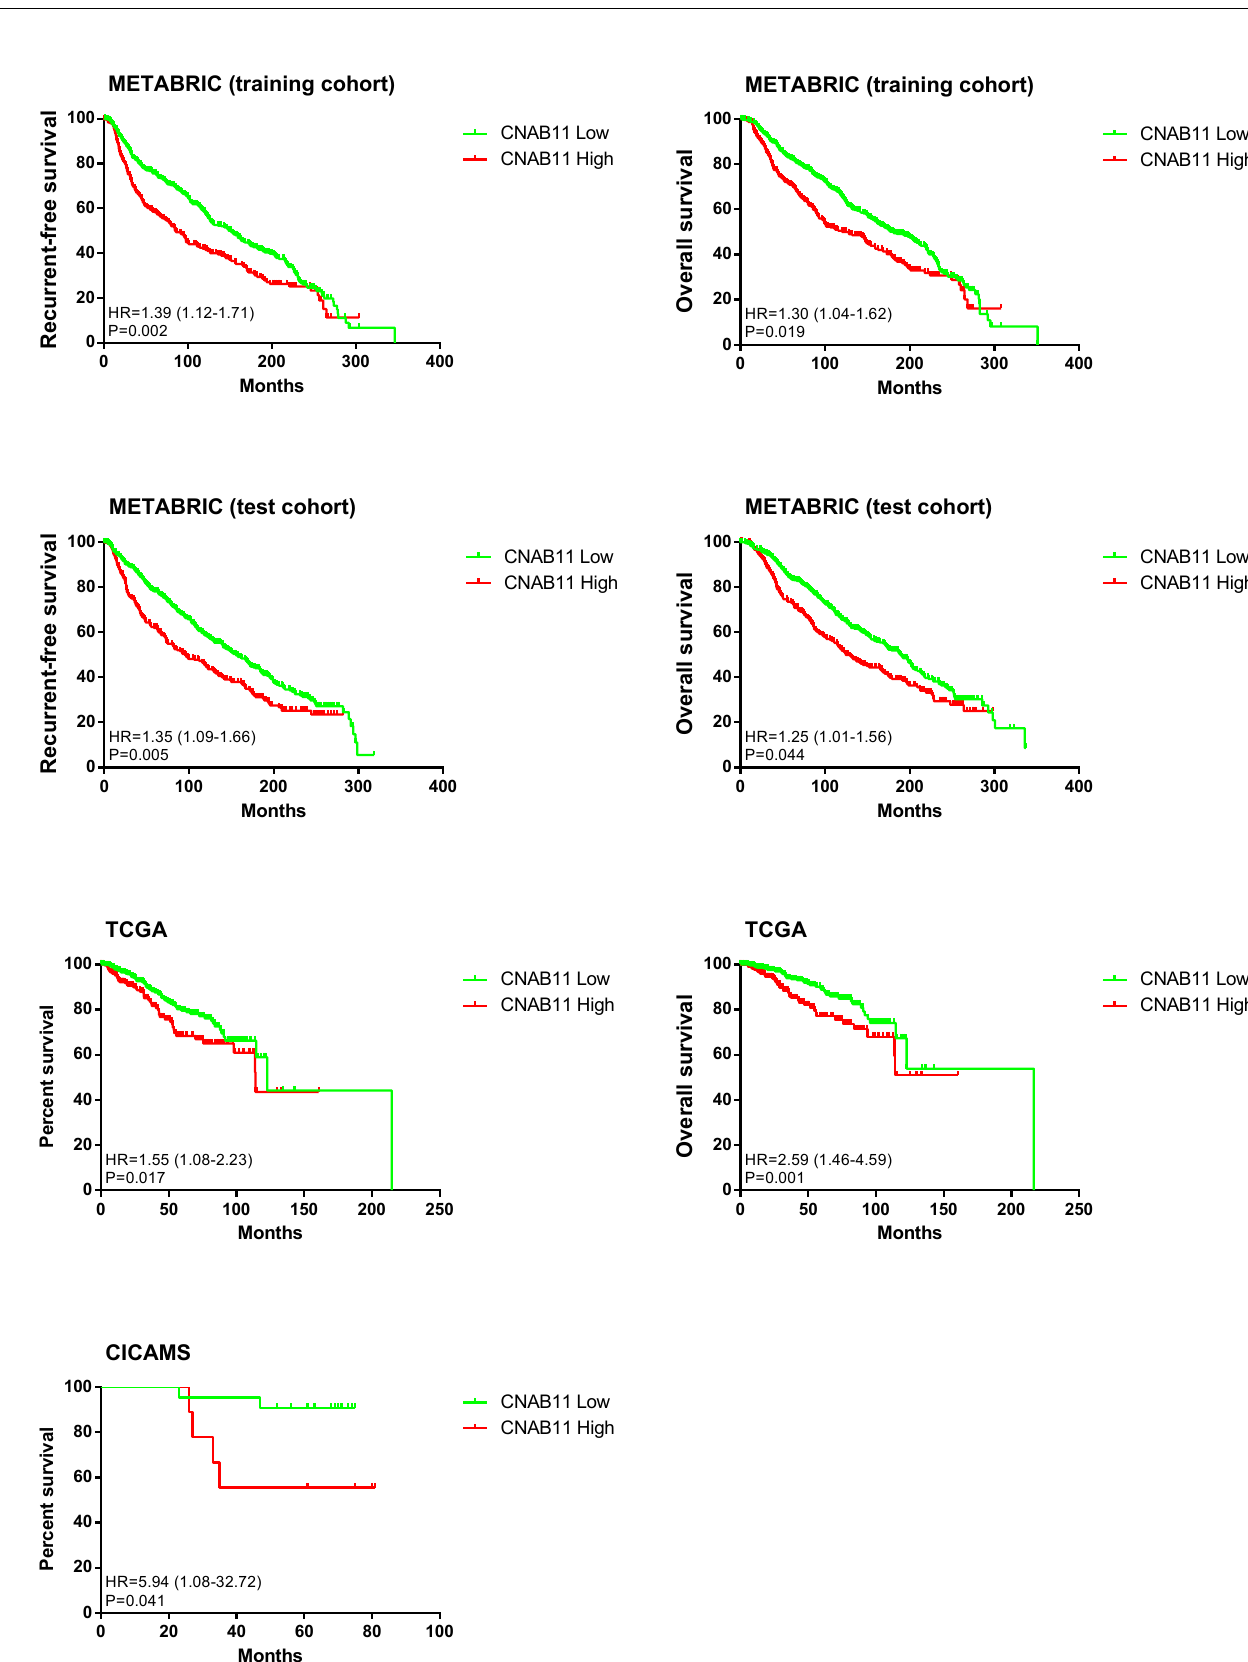
Figure 3. Survival analysis on relapse-free survival and overall survival of patients in METABRIC, TCGA, and CICAMS between the CNAB11-high group and CNAB11-low